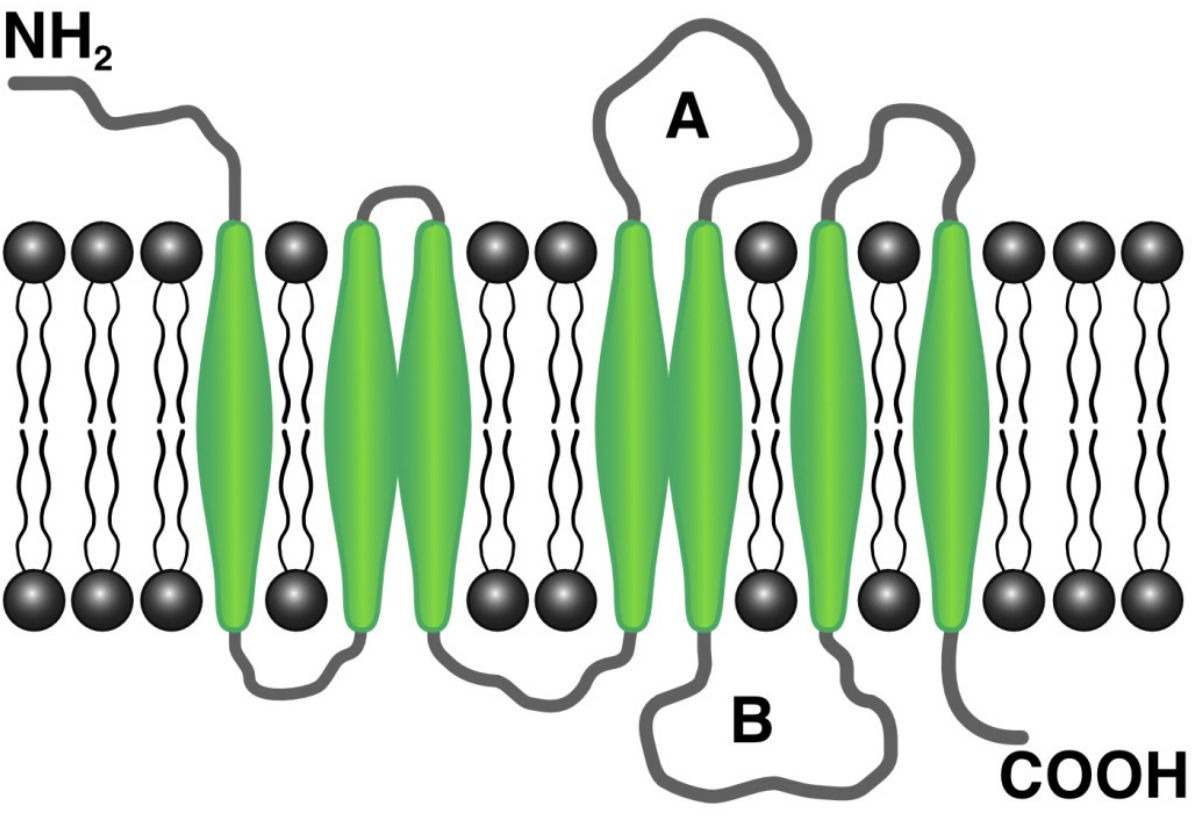
Figure 1. CB1R structure. (A) Second outer loop agonist attachment site. (B) Third inner loop G protein attachment site.